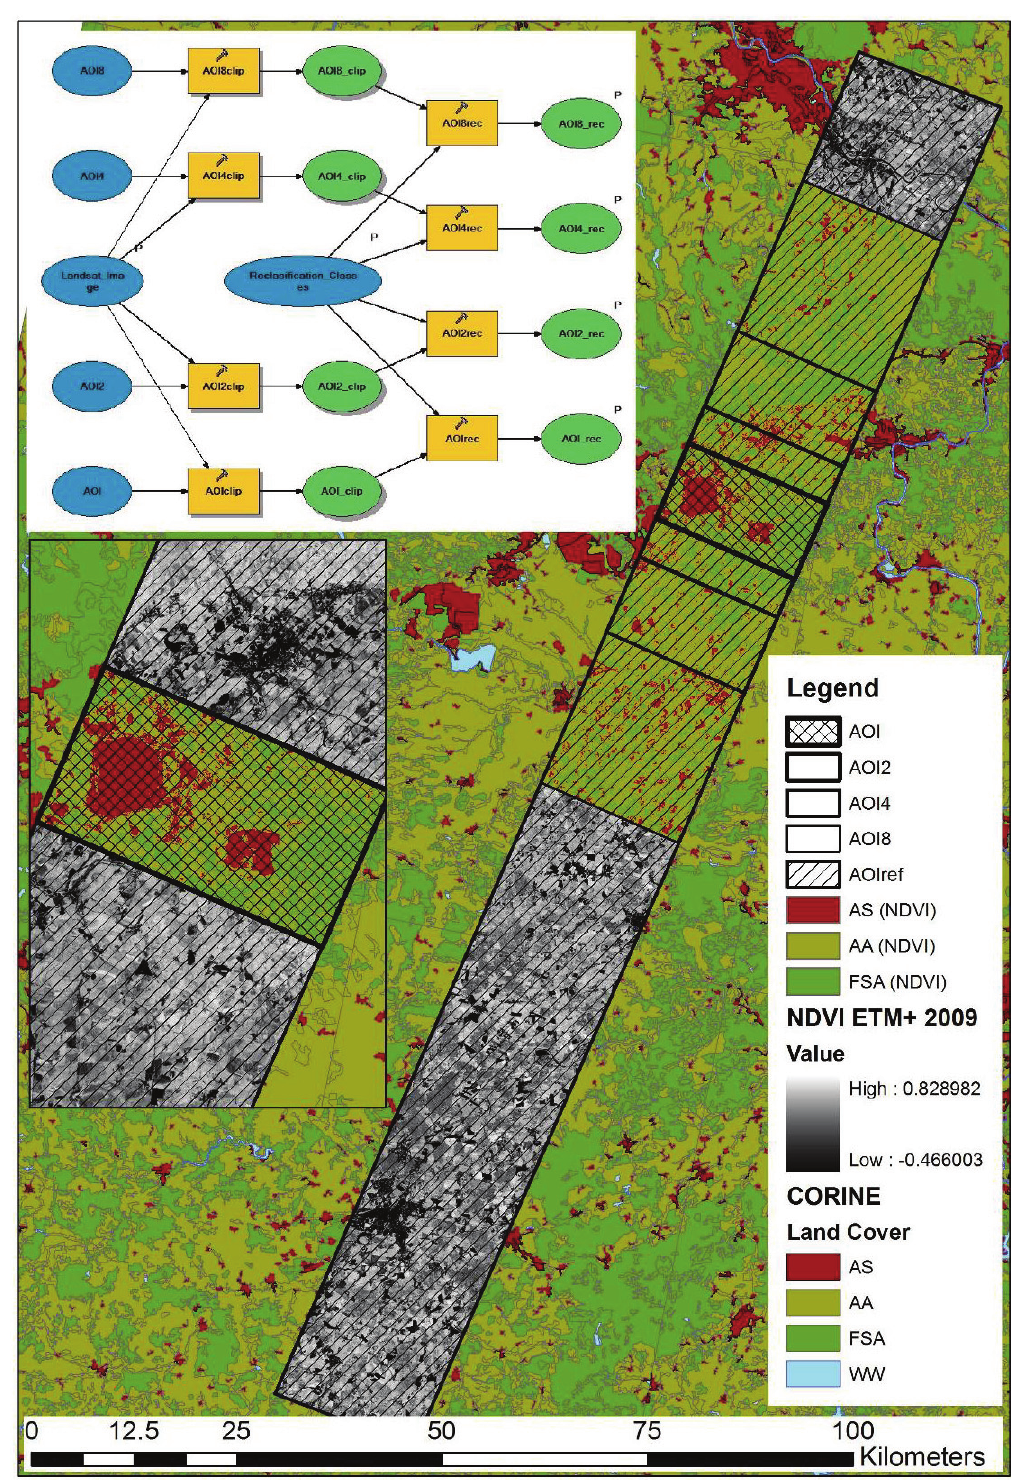
Figure 3. A few areas of interest, AOIs, selected for exploration of land-cover classes in a Landsat strip, AS: artificial surfaces, AA: agricultural areas, FSA: forest-seminatural areas, WW: wetlands-water